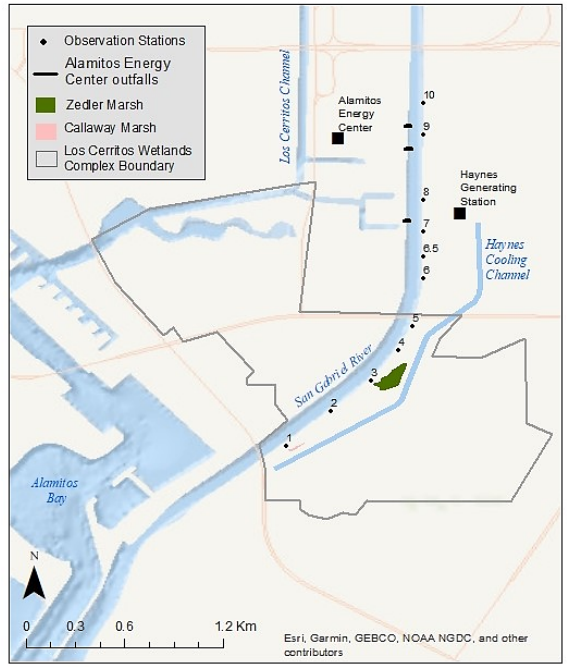
Figure 2. The Aquarium’s Citizen Science Monitoring Area. Stations 1 through 10 are observation stations. Station 6.5 is a training station; sightings data collected from this training location are not utilized in data analysis, to ensure data integrity. Stations 6, 6.5, and 7 are located directly above outfalls from the Haynes Generating Station. Alamitos Energy Center outfalls are labeled